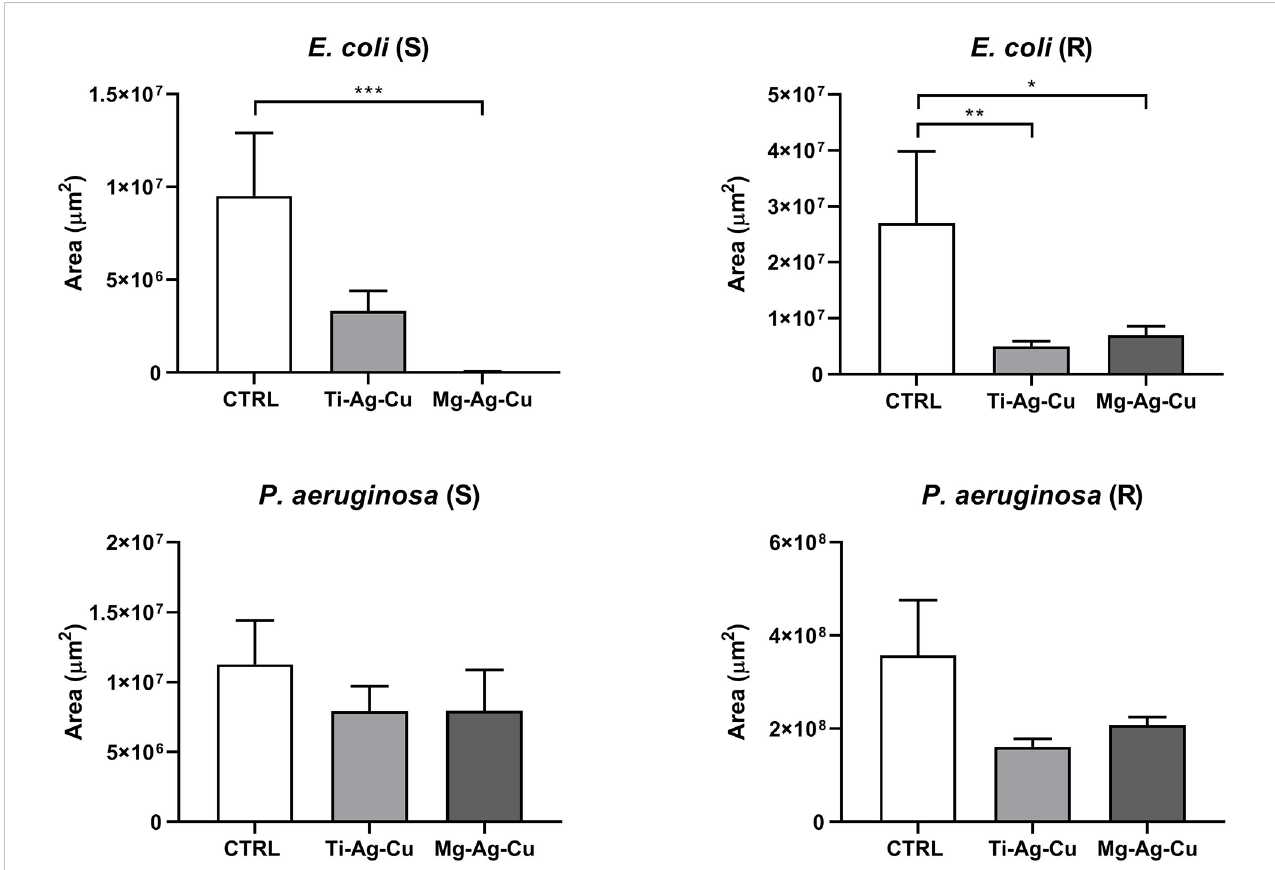
FIGURE 8 Effect of Ti-Ag-Cu and Mg-Ag-Cu coating on E. coli (S and R) and P. aeruginosa (S and R) colonization compared to uncoated glass discs (CTRL) analyzed by means of CLSM. Statistical signi fi cance: p < 0.05 (*), p < 0.01 (**) and p < 0.001